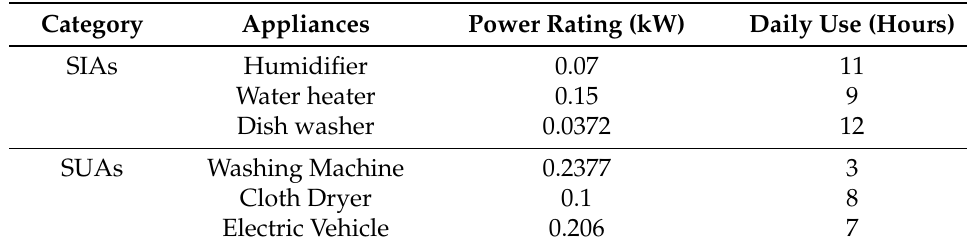
Table 2. Description of